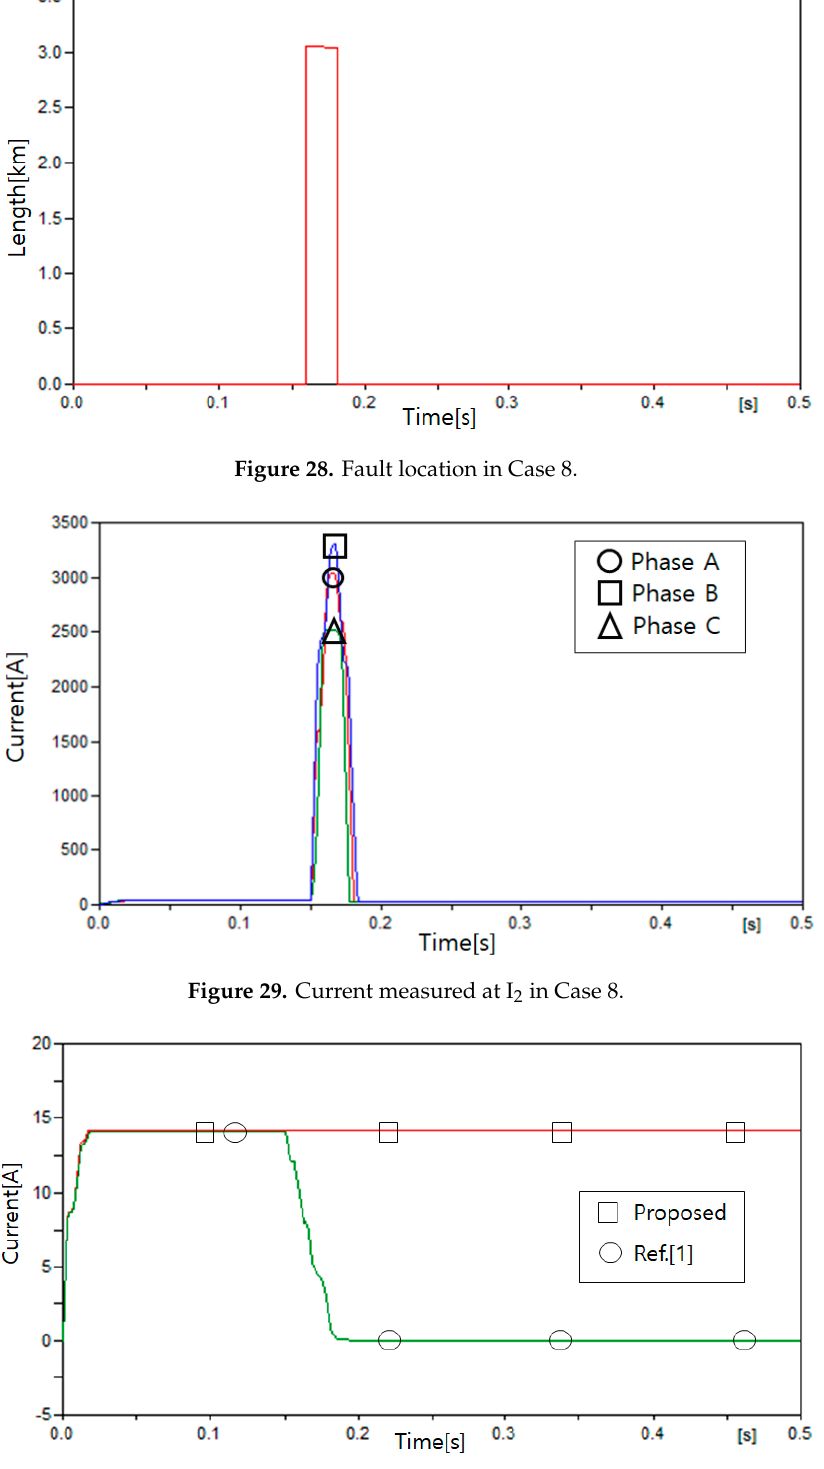
Figure 30. Current measured at Load 6 in Case 8.